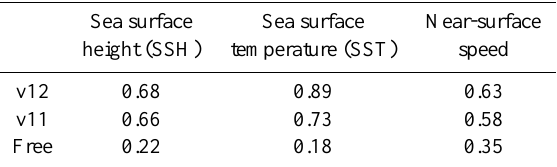
Table 4. Anomaly correlations for modelled SSH, SST and the magnitude of near-surface velocity fields (speed) against the corre- sponding gridded observational products (AVISO, OSTIA and OS- CAR) for all the 2-D spatial maps shown in Fig. 10. Correlations are calculated over all ocean points, and anomalies are calculated rel- ative to the WOA2001 1 / 4 ◦ analysis (Boyer et al., 2005) for SST, the CNES09 MDT (Rio et al., 2011) for SSH and the GDP drifter climatology (Lumpkin and Garraffo, 2005) for the speed. Sea surface Sea surface Near-surface